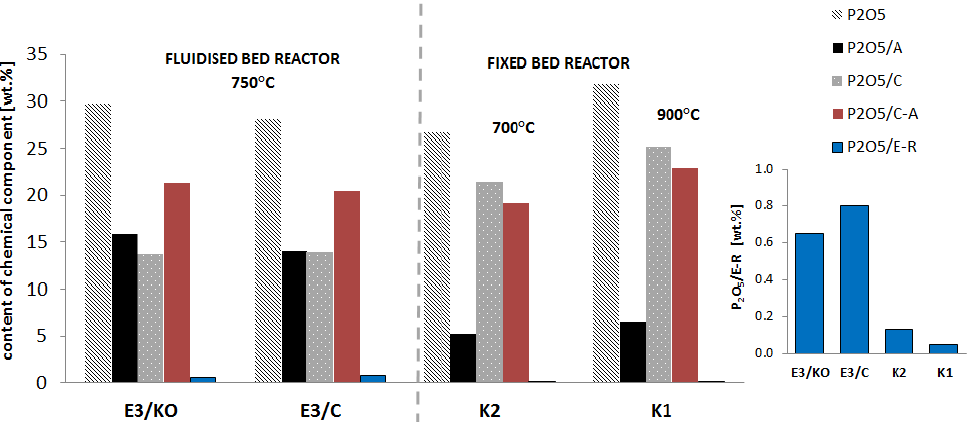
Figure 10. Comparison of the content of different forms of phosphorus in ash obtained from the combustion of poultry manure in a fluidised bed reactor (samples E3/KO, E3/C—own work) and a fixed bed reactor (samples K2, K1—[31]). Annotations: P 2 O 5 /A—phosphorus content in the amorphous phase, P 2 O 5 /C—phosphorus content in the crystalline phase, P 2 O 5 /C-A—the content of phosphorus easily soluble in citric acid, P 2 O 5 /E-R—the content of phosphorus easily soluble in 0.04 M calcium lactate solution.